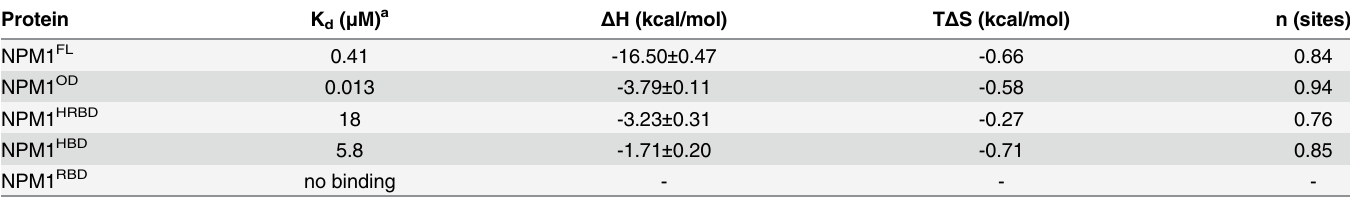
Table 2. ITC data for HIV-1 Rev FL interaction with NPM1 variants. Protein